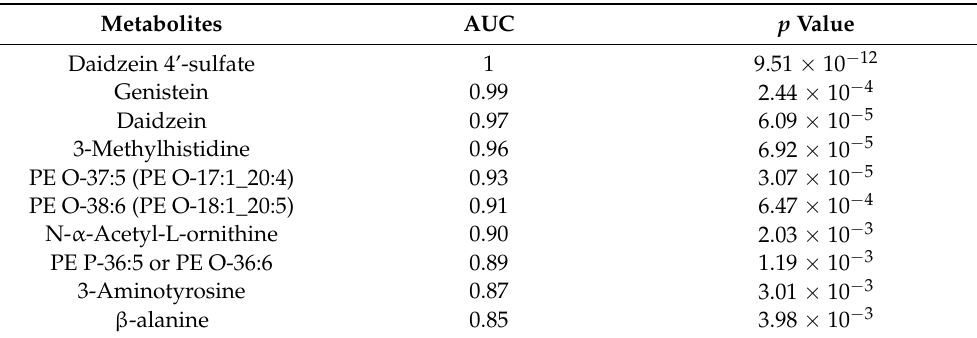
Table 4. Area under the curve-receiver operating characteristics (AUC-ROC) curves for the top 10 plasma metabolites.